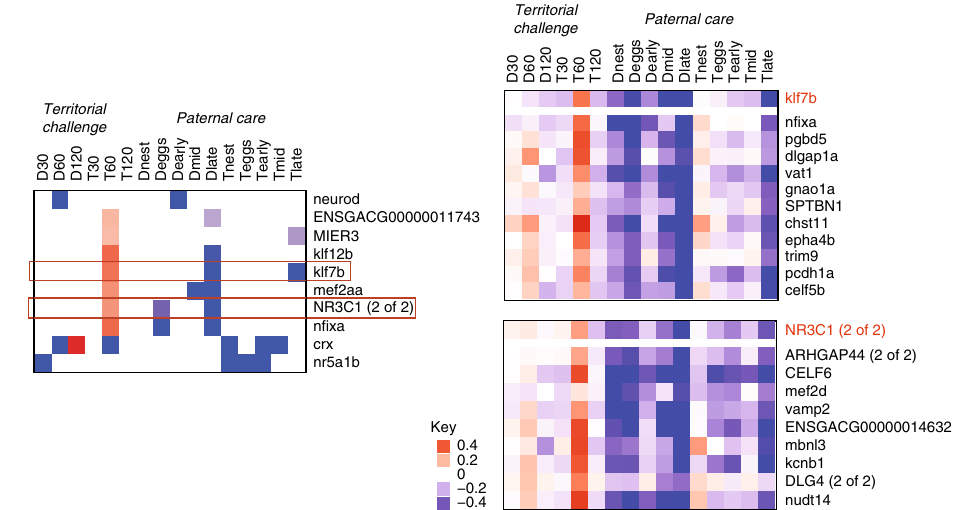
Fig. 5 Shared regulators of a territorial challenge and paternal care. The panel on the left shows the expression pattern of the 10 transcription factors that were enriched in both experiments (Fig. 4). Columns are conditions within the two experiments (30, 60 or 120 min after a territorial challenge, the fi ve stages of paternal care in diencephalon (D) or telencephalon (T)). Note that 8 of the shared transcription factors were regulated in opposite directions and in different brain regions in the two experiments. The two panels on the right show the expression pattern of two examples of shared, differentially regulated transcription factors ( Klf7b and NR3C1 ) and their targets across all of the conditions. Source data are in GEO